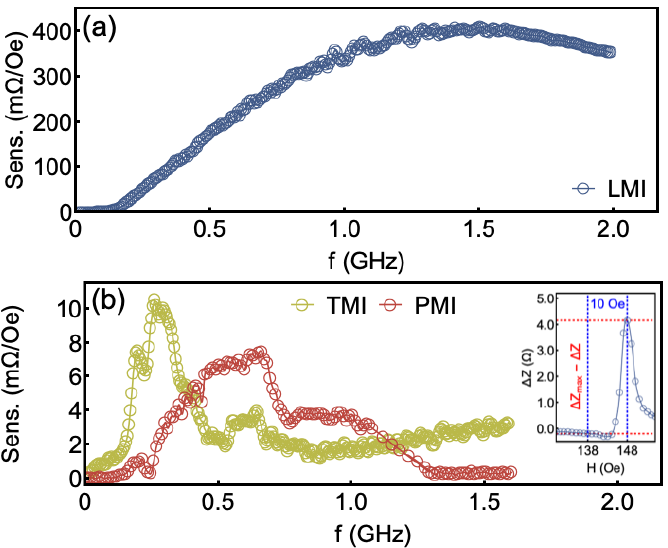
Figure 7. ( a ) Sensitivity as a function of frequency for the LMI field configuration. The maximum value is 415 m Ω /Oe at 1.5 GHz. ( b ) A similar plot for the TMI and PMI configurations. The inset depicts a representative example of the experimental procedure employed to calculate the